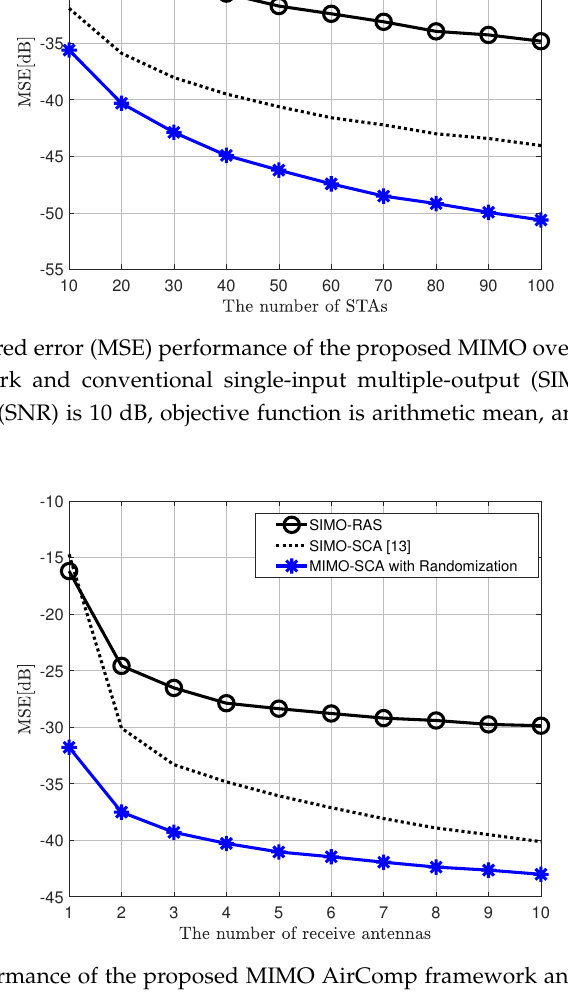
Figure 3. MSE performance of the proposed MIMO AirComp framework and conventional SIMO AirComp, when SNR is 10 dB, objective function is arithmetic mean, and N T = 2 (in MIMO AirComp), K =